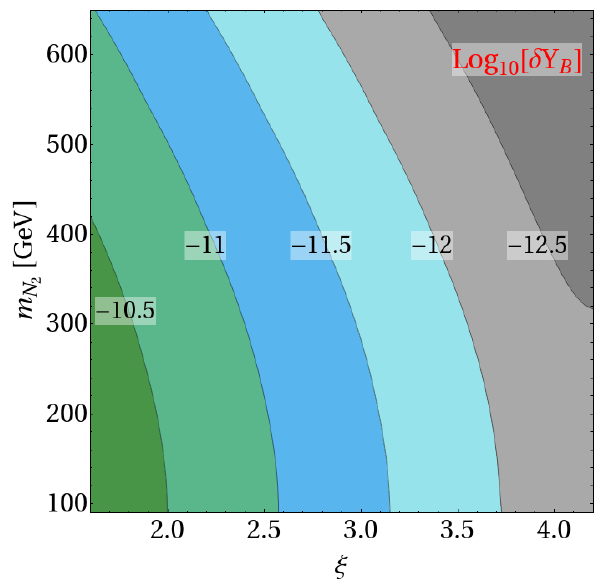
Figure 7. Same as (cid:12)gure 6a but with only ARS contribution taken into account. This